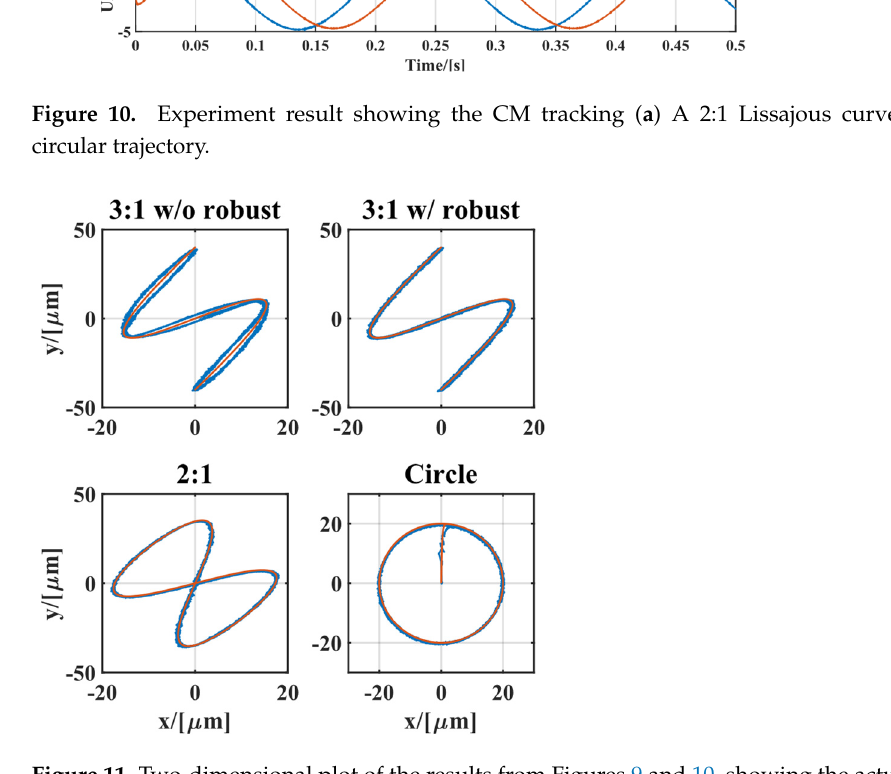
Figure 11. Two ‐ dimensional plot of the results from Figures 9 and 10, showing the actual trajectory of the closed ‐ loop CM. of the closed-loop